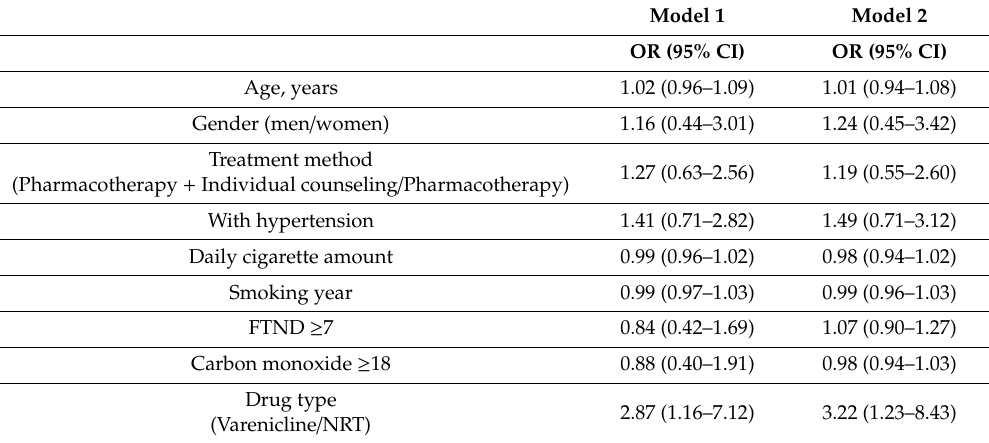
Model 1: univariate logistic regression. Model 2: multivariate logistic regression. Abbreviations: FTND = Fagerström test for nicotine dependence; NRT = nicotine replace